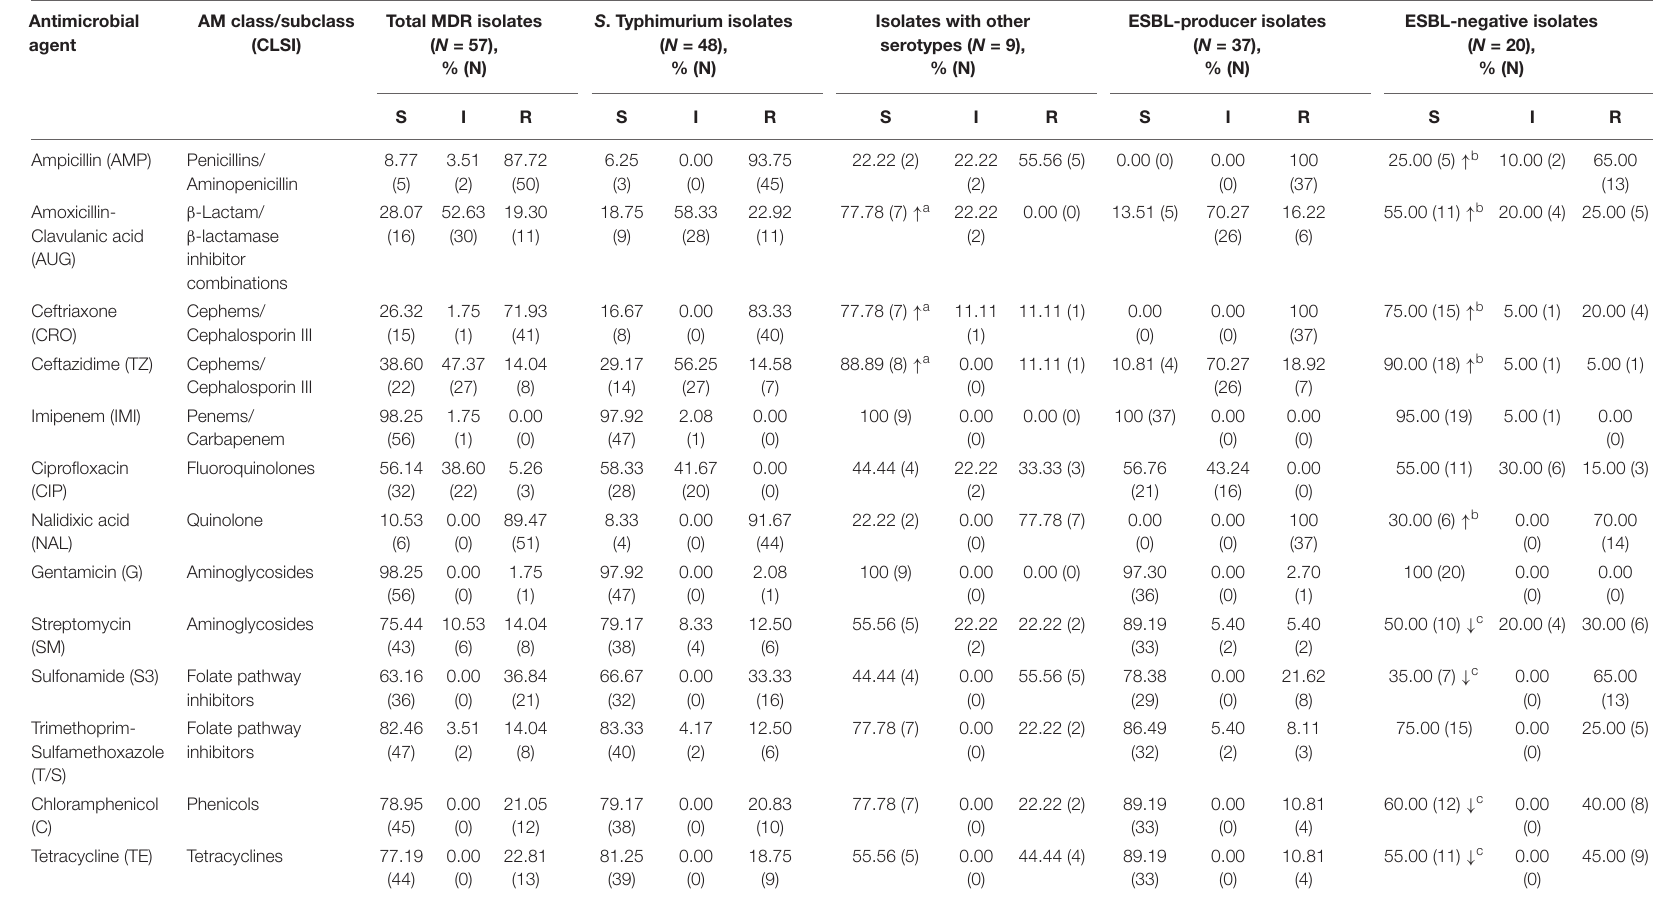
TABLE 1 | Susceptibility to antimicrobials in multidrug-resistant isolates of non-typhoidal Salmonella recovered from patients in Armenia (54 isolates) and Georgia (3 isolates). Antimicrobial